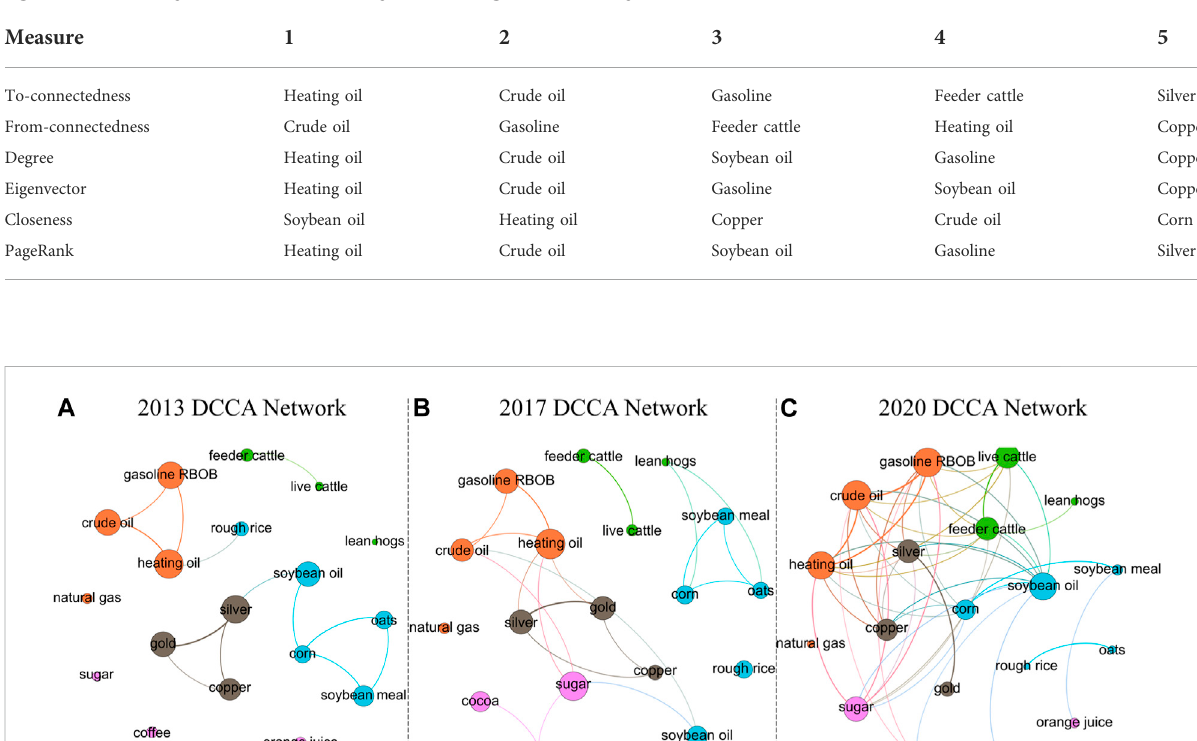
TABLE 2 Top fi ve commodity future markets with the highest values for to-connectedness C to i , from-connectedness C from